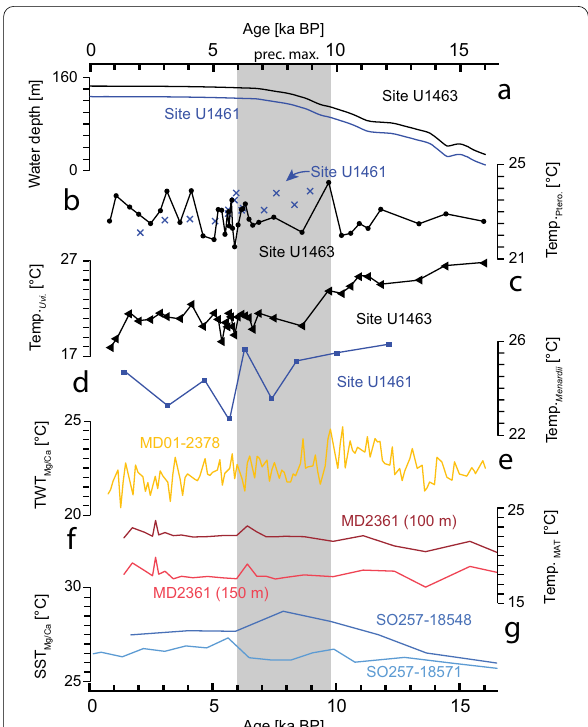
Fig. 5 Water temperature proxies at Sites U1461 and U1463 as compared with regional data. The gray band indicates a precipitation maximum on the NWS (Hallenberger et al. 2019; Ishiwa et al. 2019). ( a ) Paleo-water depth at both studied sites based on the sea-level curve of Lambeck et al. (2014). The relative sea level at Sites U1461 and U1463 was not corrected for isostatic deformation. ( b ) Water temperature based on the δ 18 O values of H. inflatus . ( c ) Water temperature calculated from δ 18 O data for Uvigerina spp. at Site U1463. ( d ) δ 18 O data for the planktic foraminifera G. menardii (Courtillat et al. 2020) used to calculate past changes in upper thermocline water temperatures at Site U1461. ( e ) Past variations in thermocline water temperatures based on the Mg/Ca ratio of P. obliquiloculata at Site MD01-2378 (Xu et al. 2008). ( f ) Water temperature record from the North West Cape of Australia (MD-2361) at 100 and 150 m depth based on the modern analogue technique (Spooner et al. 2011). ( g ) Sea surface temperature changes based on the Mg/Ca ratios of G. ruber in the Timor Sea (Site SO257-18548) and offshore of northwestern Australia (Site SO257-18571; Pei et al., 2021b)